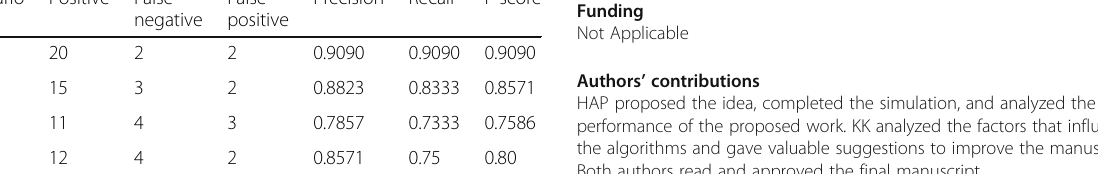
False Precision negative positive